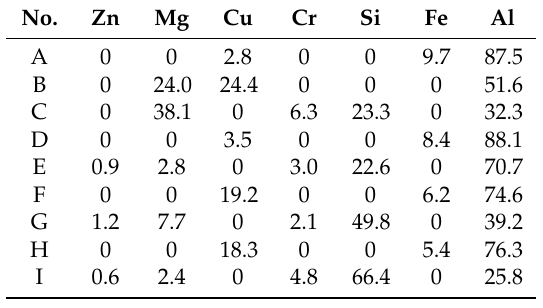
Figure 7. The XRD analysis of 7075 aluminum alloy after FSP and various heat Table 3. EDS data for specimens shown in Figure 9 (Unit: at. %).